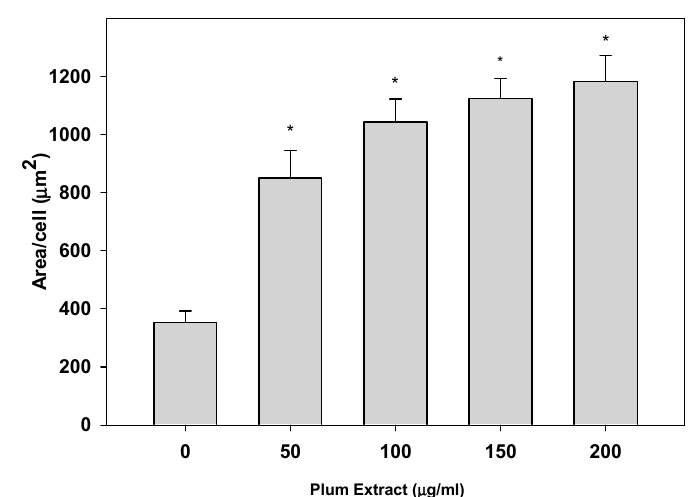
Figure 1. The effect of plum extract on C2C12 myoblast cell size. ( a ) The representative pictures of myoblast after treatment with varying concentration of plum extract (100 × magnified images) taken by a Nikon Microscope. The bar represents a length of 500 µm. ( b ) The size of myoblast was determined using Element-BR software as described in “Materials and Methods”. The data are expressed as mean ± SD for at least three experiments. All comparisons were made to control (untreated cells) using one-way ANOVA; significant differences are reported at * p < 0.05.